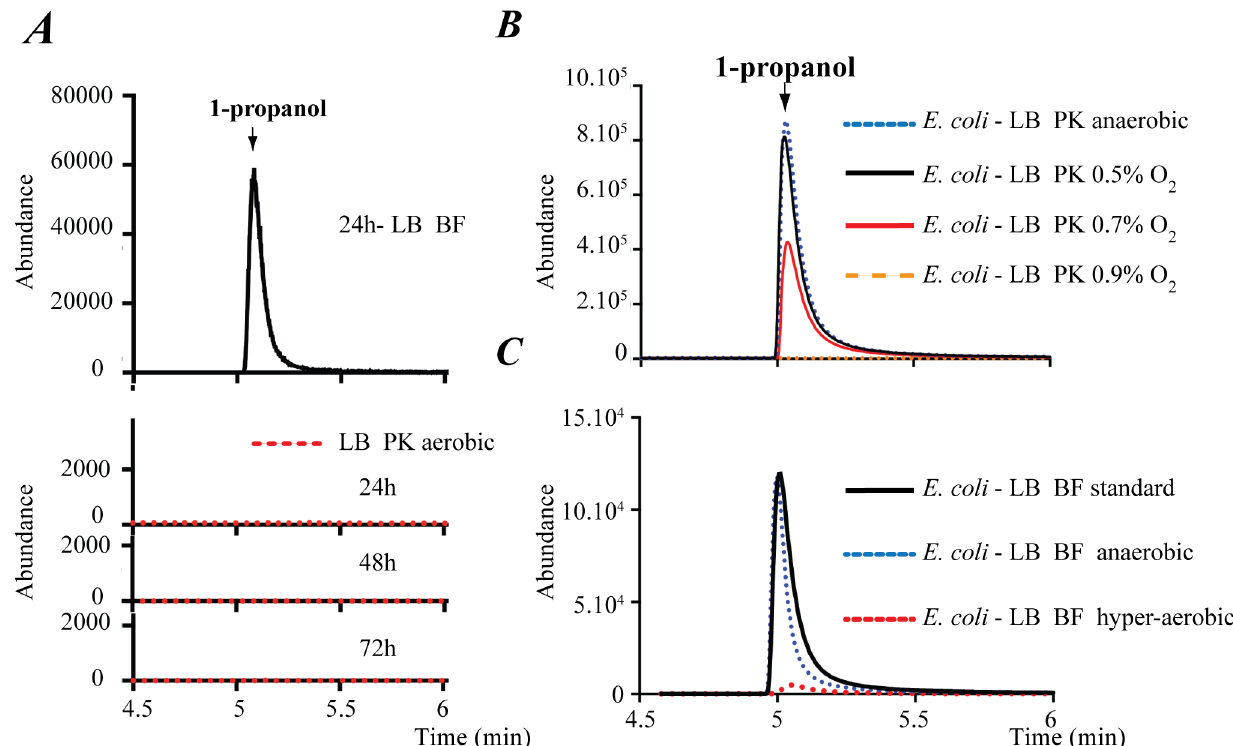
Fig 1. Influence of oxygen on 1-propanol production in E . coli cultures. ( A ) Comparisonof HS-SPME/GC-MS analysisof 1-propanol emitted by wild-type E . coli (K12 strain TG1) biofilm grown for 24 h in LB medium (definedas “standard”biofilm conditionsin Materials and Methods), or in agitatedaerobic planktonicconditionsfor 24, 48 and 72 h. ( B ) HS-SPME/GC-MS analysisof 1-propanol emitted from E . coli planktonic cultures performed in LB medium under fully anaerobicor increasinglyaerobic conditions. ( C ) HS-SPME/GC-MS analysisof 1-propanol emitted by E . coli biofilms formed in LB medium in standard, fully anaerobicor hyperaerobic conditions. Abundance:arbitrary unit proportional to the number of detected m/z ionizedfragments.